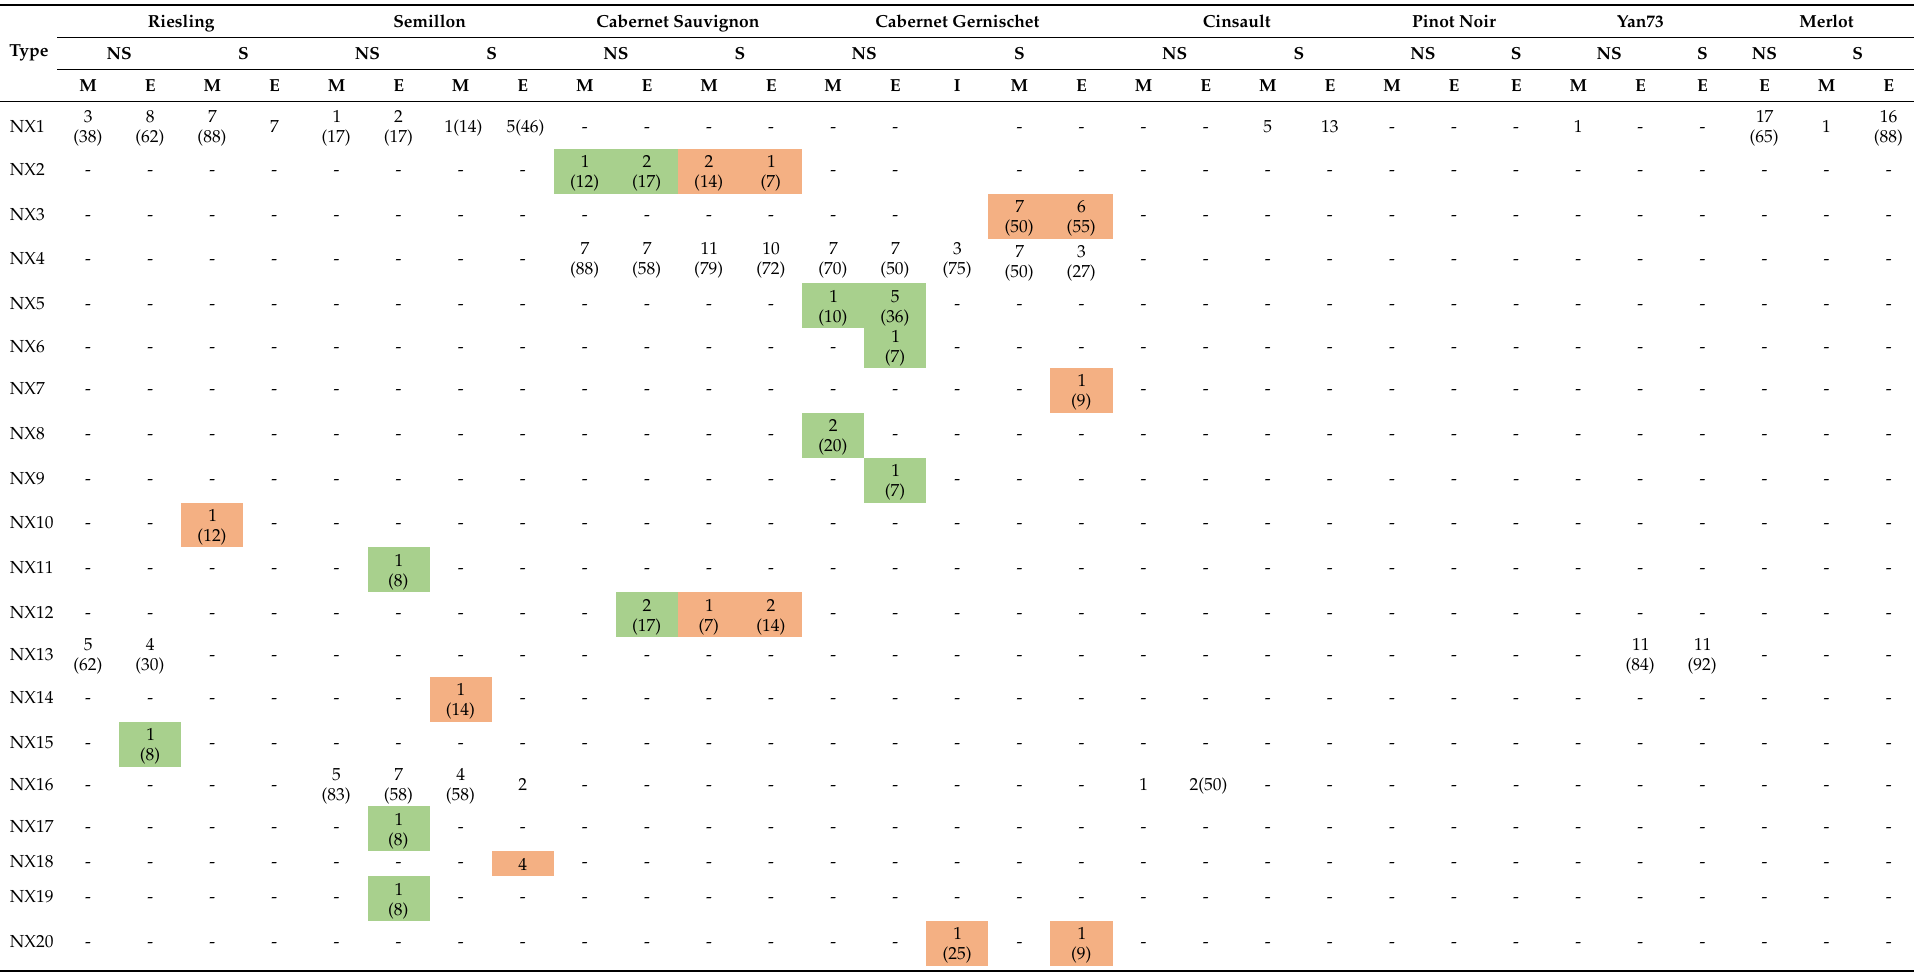
Table 1. Distribution of 33 S. cerevisiae genotypes during spontaneous fermentations with eight typical grape varieties. Numbers outside the brackets represent the number of the genotype found at each stage of fermentation whilst numbers in the brackets show the percentage of the specific